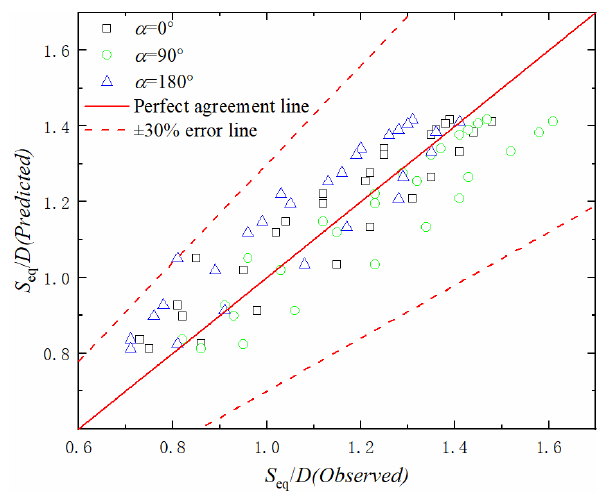
Figure 11. The relationships between S eq / D and E u for different installation angles and fitting results.